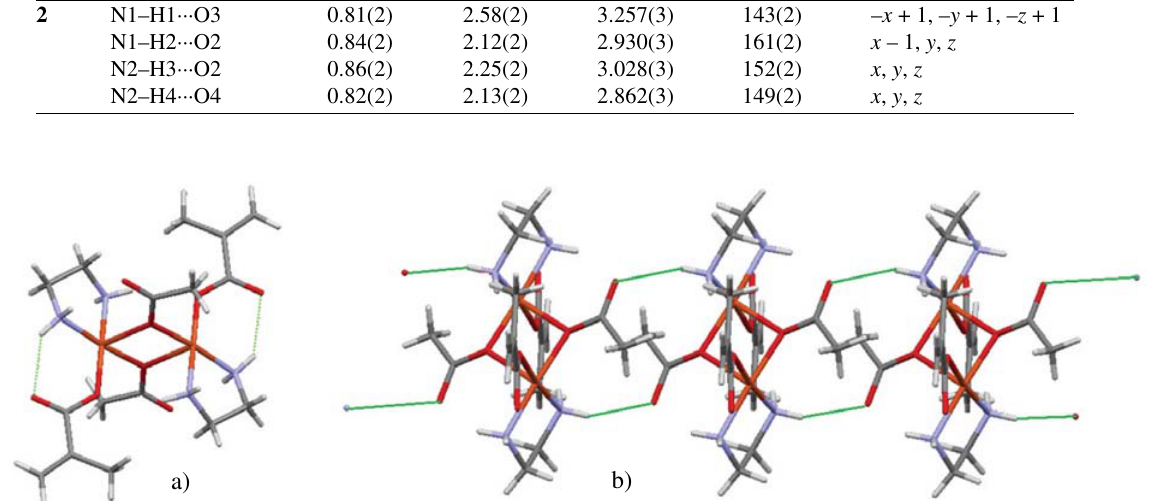
Fig. 2. Various hydrogen bonding interactions in complex 1 (a) intramolecular (b), intermolecular.